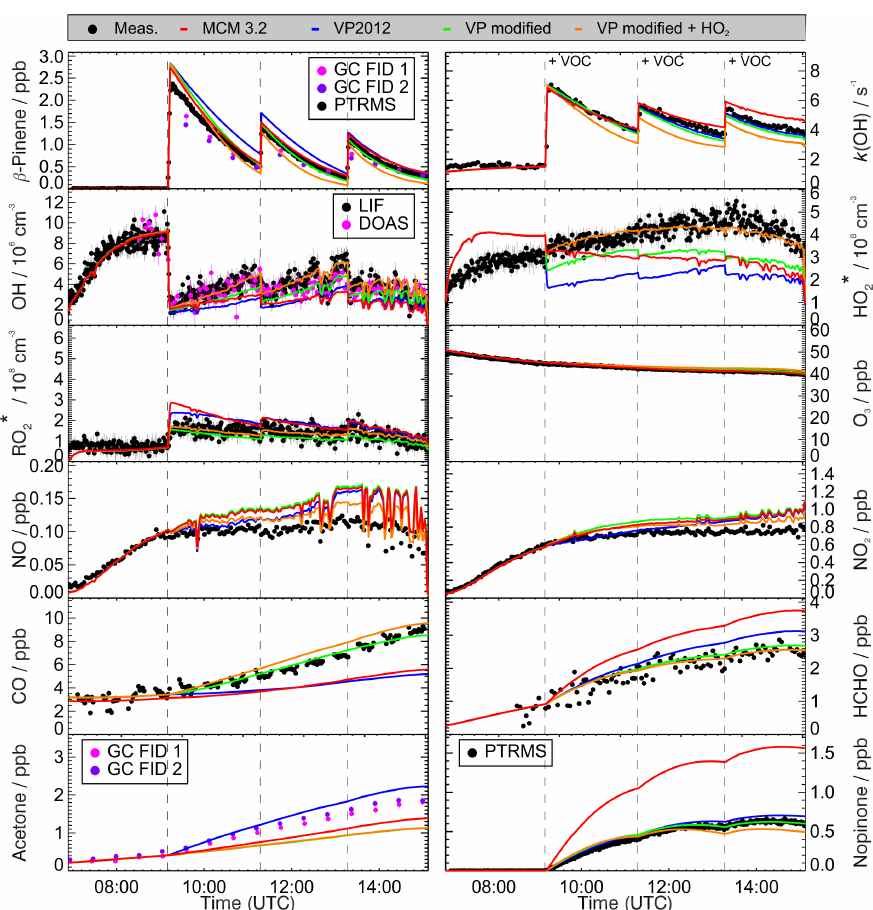
Figure 5. Comparison of the measured and modeled time series of β -pinene, OH, OH, HO ∗ nopinone in the β -pinene oxidation experiment from 27 August. Red: MCM 3.2. Blue: model by Vereecken and Peeters (2012). Green: model by Vereecken and Peeters (2012) with 1,5-H migration of ROO6R2O. Orange: modified model by Vereecken and Peeters (2012) with 1,5-H migration of ROO6R2O and an additional production term for one molecule of HO 2 and